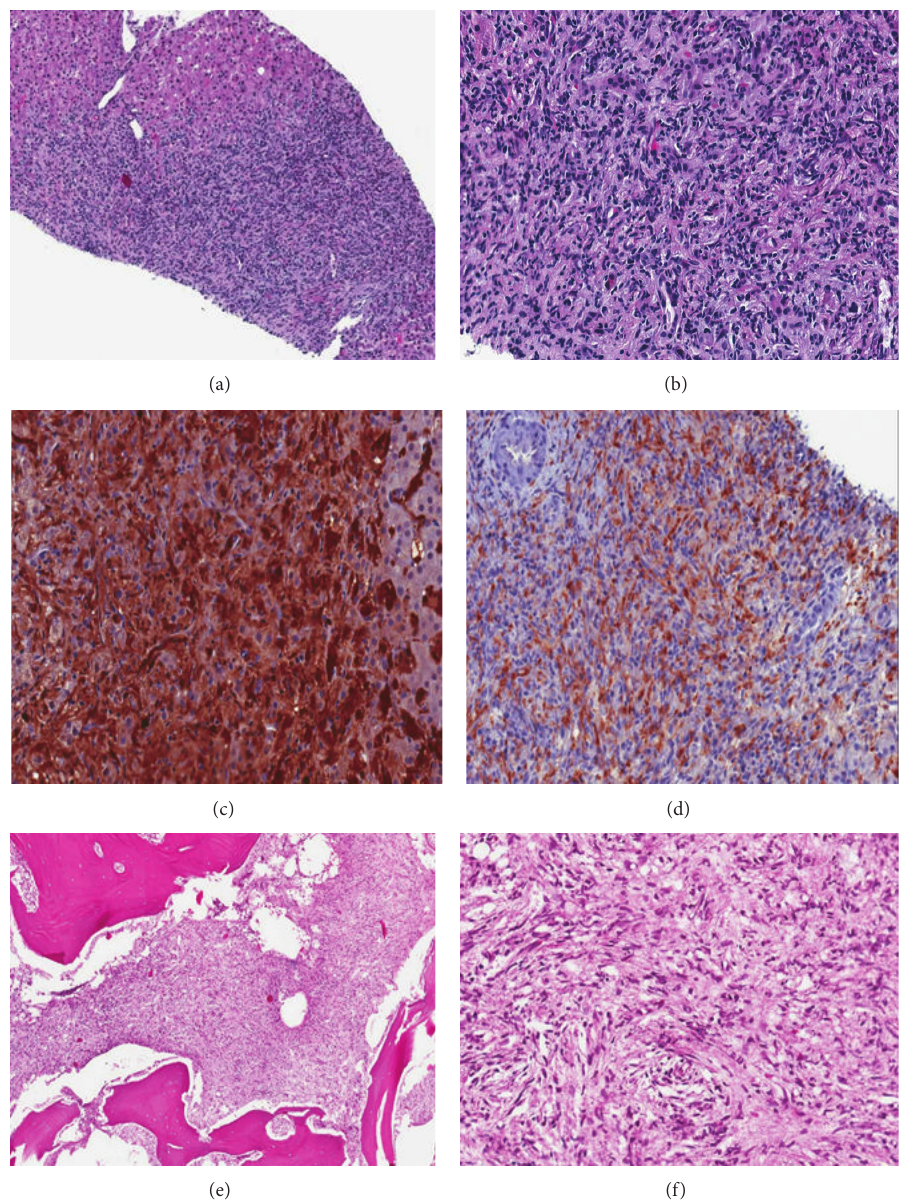
Figure 2: Histologic appearance of IMT lesions in liver and lumbar spine. (a) and (b) Liver tissue with marked inflammatory cells and spindle cell proliferation expanding portal areas and extending into parenchyma. Adjacent normal liver is seen on upper left corner of (a), (H&E), 5x (a) and 20x (b). (c) Spindle cells show strong and diffuse immunoreactivity to SMA, 20x. (d) Spindle cells are immunoreactive for cytoplasmic anaplastic lymphoma kinase protein (ALK-1), 20x. (e) and (f) Lumbar spine is infiltrated by similar mixture of inflammatory and spindled cells expanding the bone marrow, H&E, 5x and